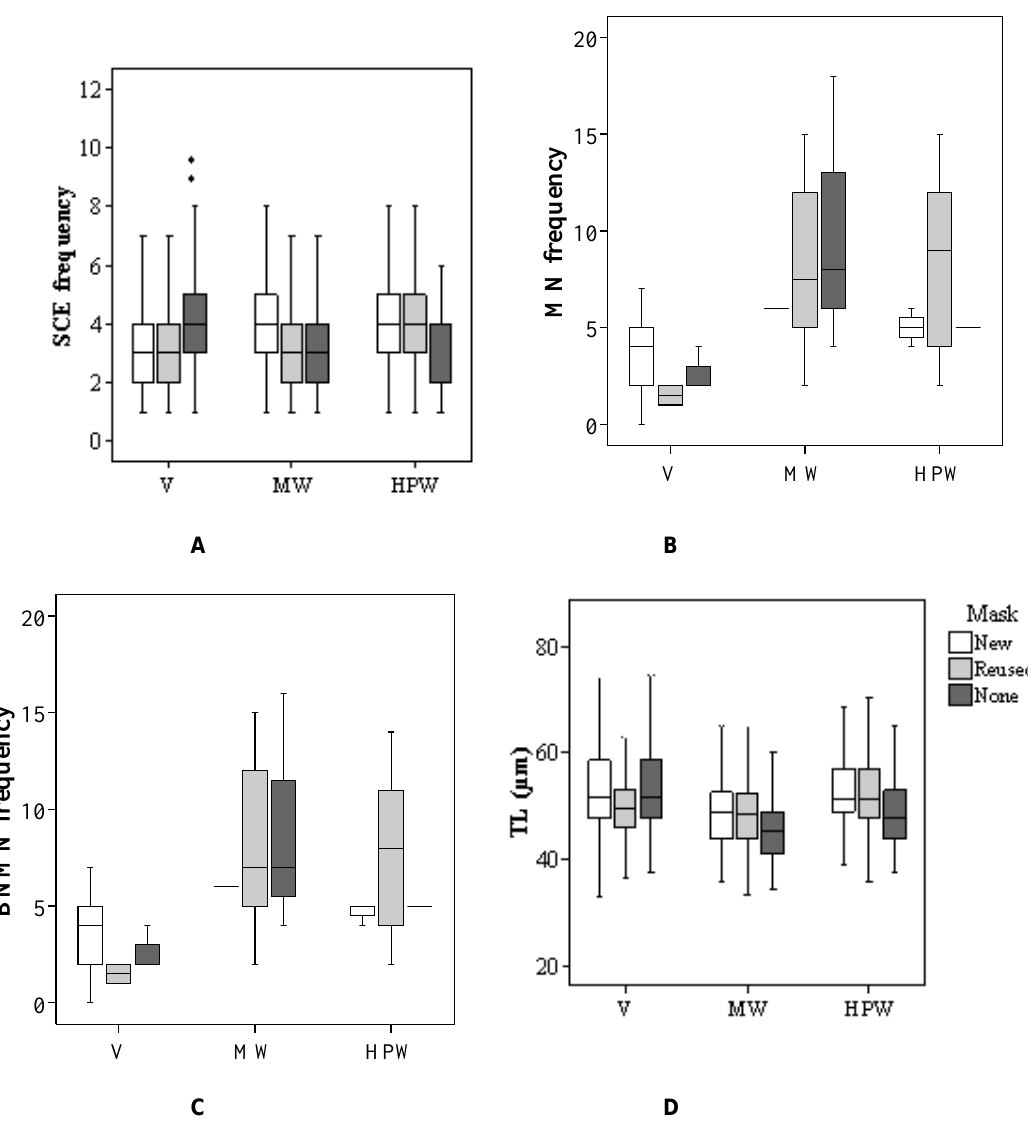
FIGURE 4. Boxplots showing SCE frequencies (a), MN frequencies (b), BNMN frequencies (c), and TL (d) in the exposed groups according to the use of protective mask. ** p < 0.01, significant difference with regard to the use of new devices.